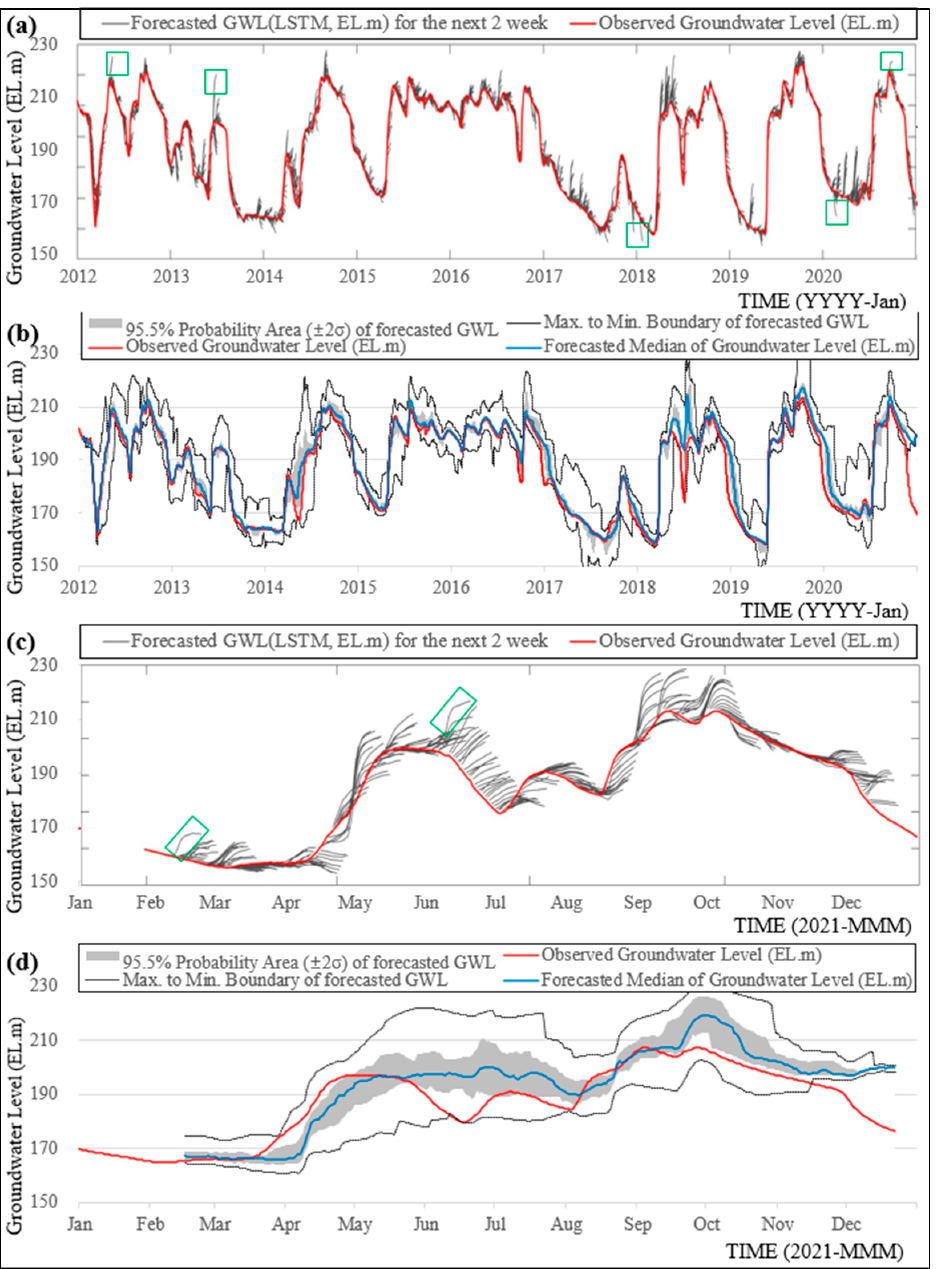
Figure 8. Attractor-concept multiple forecasting results of GWL in daily scale: ( a ) multiple forecasting in the learning period (2012 – 2020); ( b ) ensemble result in the learning period; ( c ) multiple forecasting in the validation period (2021); ( d ) ensemble result in the validation period. Green-box in ( a , c ) indicates forecasted series excluded from the estimation of forecasted groundwater level.